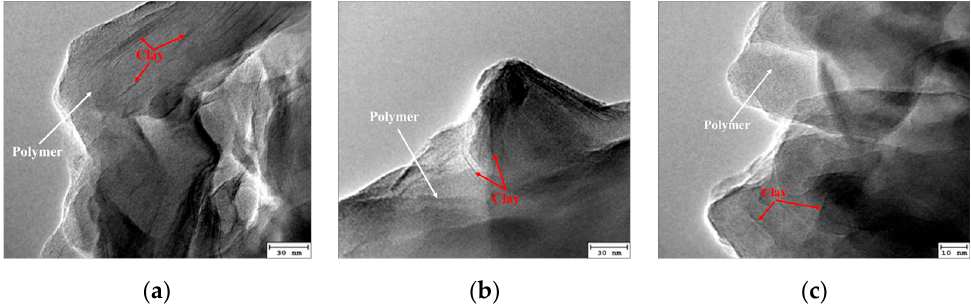
Figure 6. TEM images of the intercalated polymer synthesized under different initiator concentrations: ( a ) 1.0 × 10 − 4 ; ( b ) 1.5 × 10 − 4 ; ( c ) 2.5 × 10 − 4 .